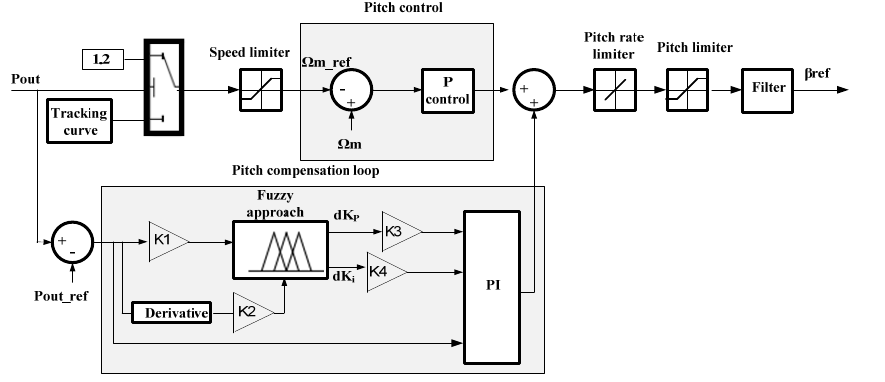
Figure 5. Pitch angle control with fuzzy adaptive PI.